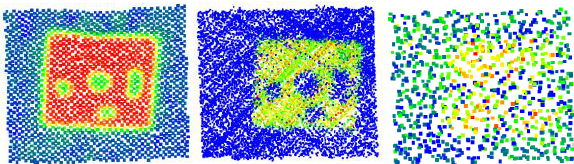
Figure 3. 1x1 m point cloud clips with targets respectively (from left to right) from the photogrammetric, VUX- 120 and miniVUX-3 survey. Blue-green-red color scale is intensity from the lowest value to the highest value.